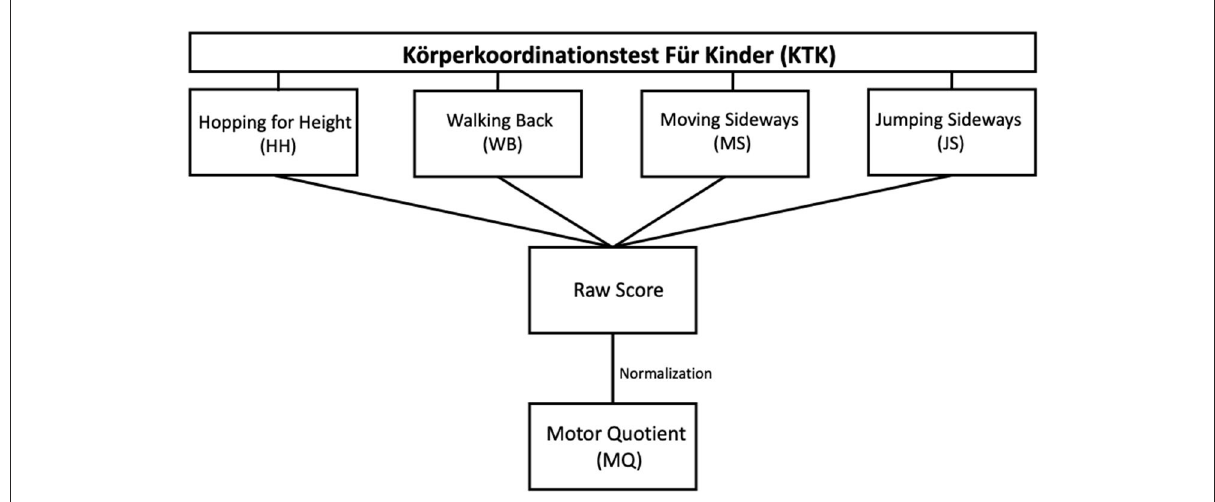
FIGURE1 KTK test setup of 4 items.